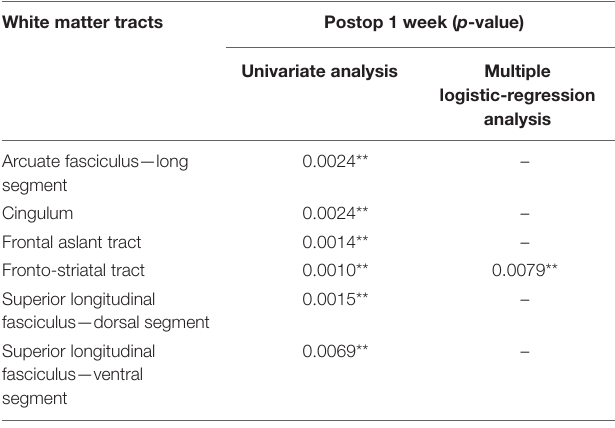
TABLE 3 | Relationship between resected volume of white matter tracts and attentional